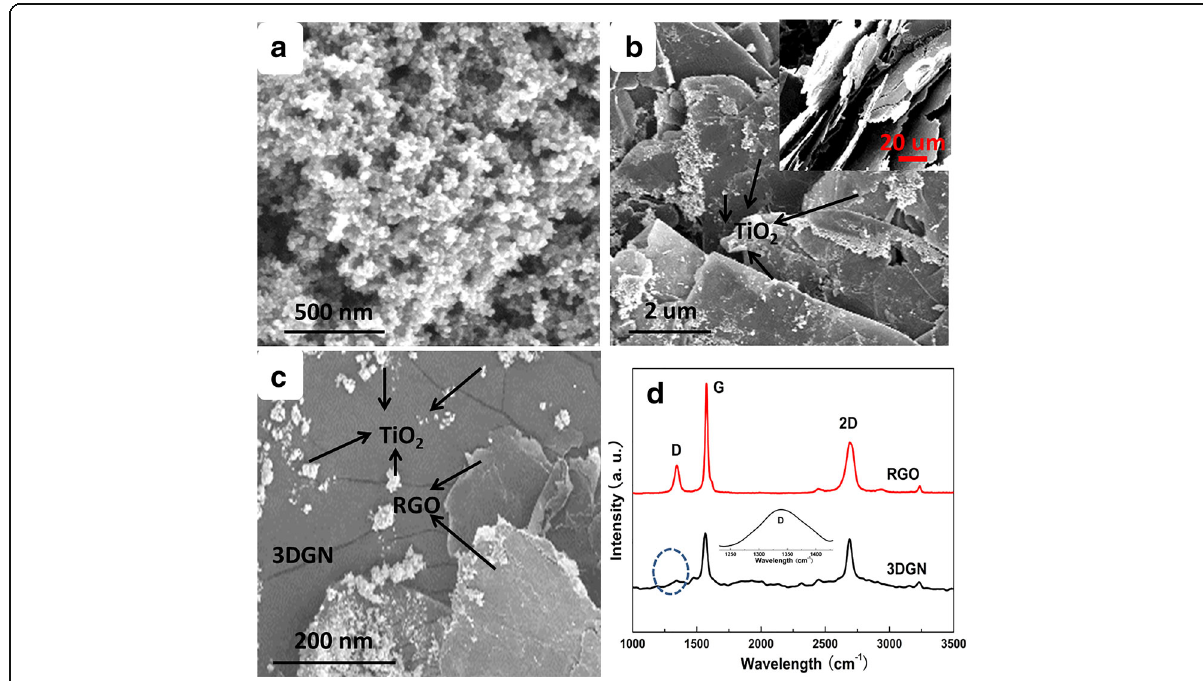
Fig. 1 SEM images of the a pure TiO 2 b 3DGN-TiO 2 , inset is the pristine 3DGN, c RGO – 3DGN – TiO 2 , and d Raman curves of the RGO and 3DGN; the D peak of the 3DGN is magnified. The images a – c show SEM images of the pure TiO 2 , 3DGN – TiO 2 , and RGO – 3DGN – TiO 2 . Therein, the inset of image b is the SEM image of origin 3DGN. Figure d display Raman curves of the RGO and 3DGN, the D peak of the 3DGN is magnified. The obvious wrinkle on surface of the 3DGN, which is closely related to its adsorption ability (for pollutants) and loading capacity (for TiO 2 ), is caused by the distinction between thermal expansion coefficients of graphene and Ni